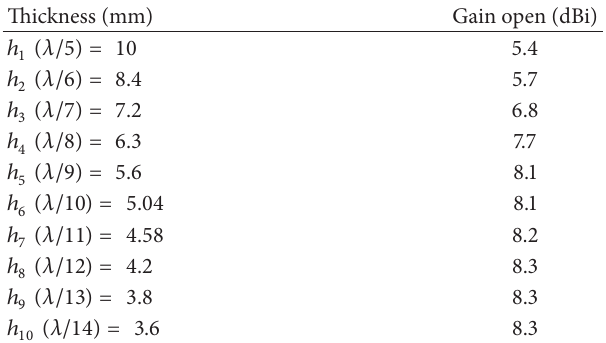
Table 4: Antenna gain substrate thickness